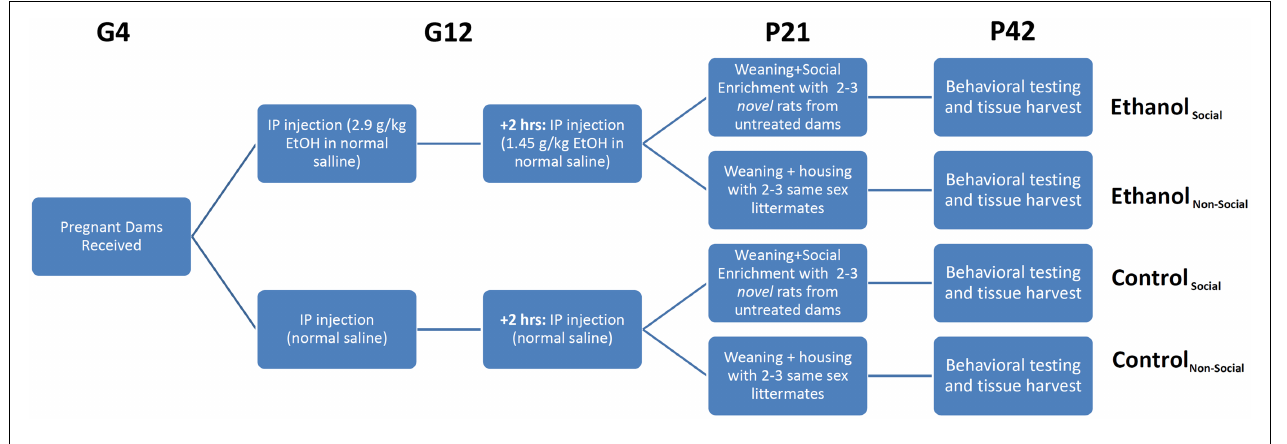
(P21-42), during which they were housed with 2–3 age- and sex-matched rats from their own litter or a novel litter from an untreated dam, respectively. All animals underwent behavioral testing using the social interaction test (SIT), which measures social investigation, contact behavior, play fighting, and social motivation (social preference vs avoidance for the novel rat). After testing, rats were euthanized and tissue harvested for RNA